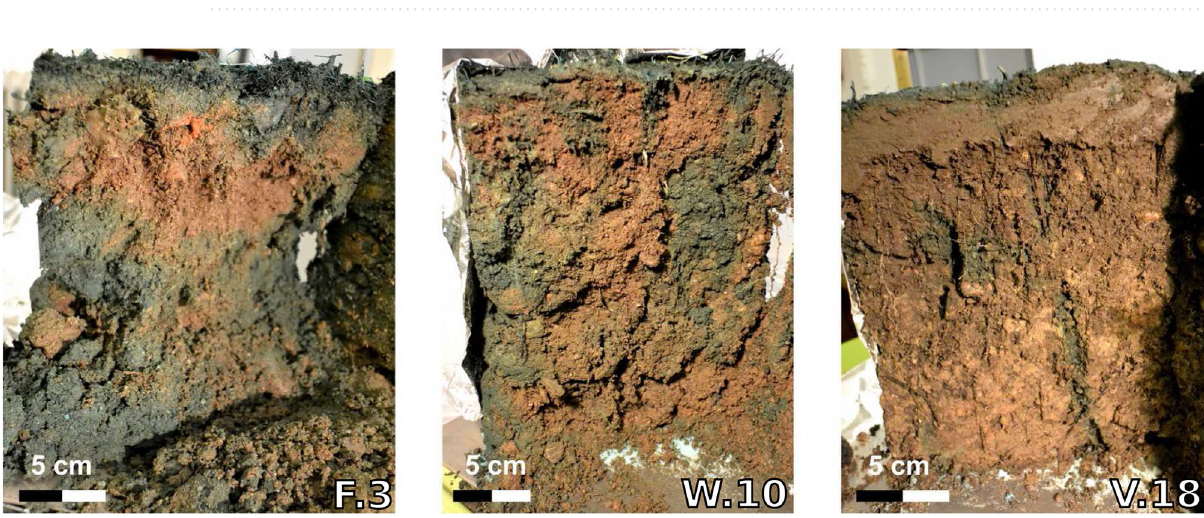
Figure 3. Brilliant blue stained soil columns (F.3, W.10 and